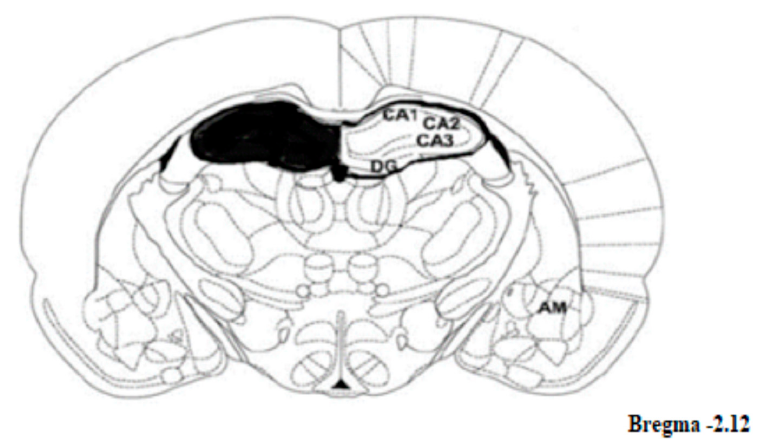
Figure 2. Schematic drawing of the rat hippocampus area that was taken—CA1, CA3 and the dentate gyrus (DG). Figure was taken from: http://labs.gaidi.ca/rat-brain-atlas/?ml=-2.5&ap=-3.8&dv=1.6, accessed on 15 July 2022.